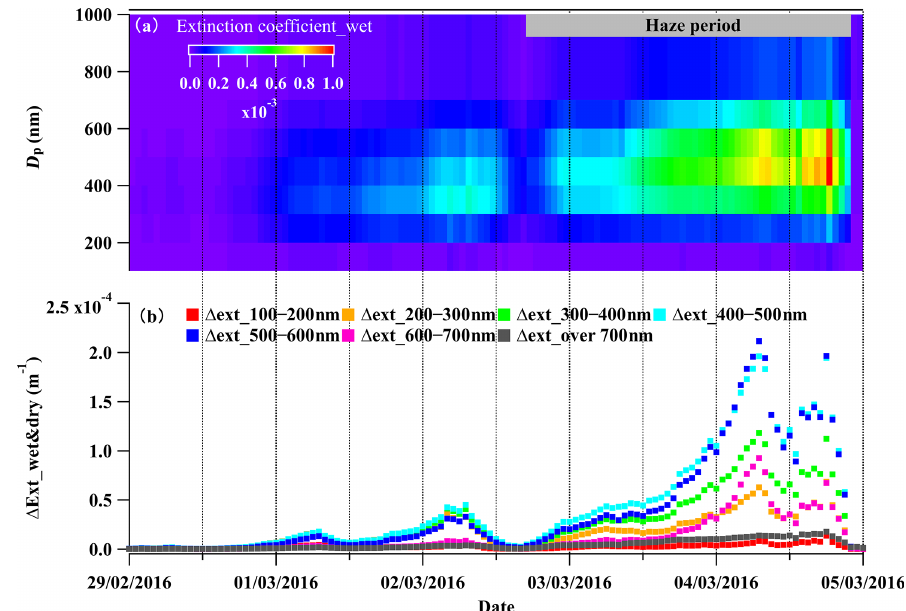
Figure 8. (a) The size-segregated light extinction coefficient at a wavelength of 550nm for wet particles (Extinction coefficient_wet) and (b) the size-segregated difference between Extinction coefficient_wet and Extinction coefficient_dry, representing the light extinction coef- ficient difference with and without considering liquid water during 29 February to 5 March